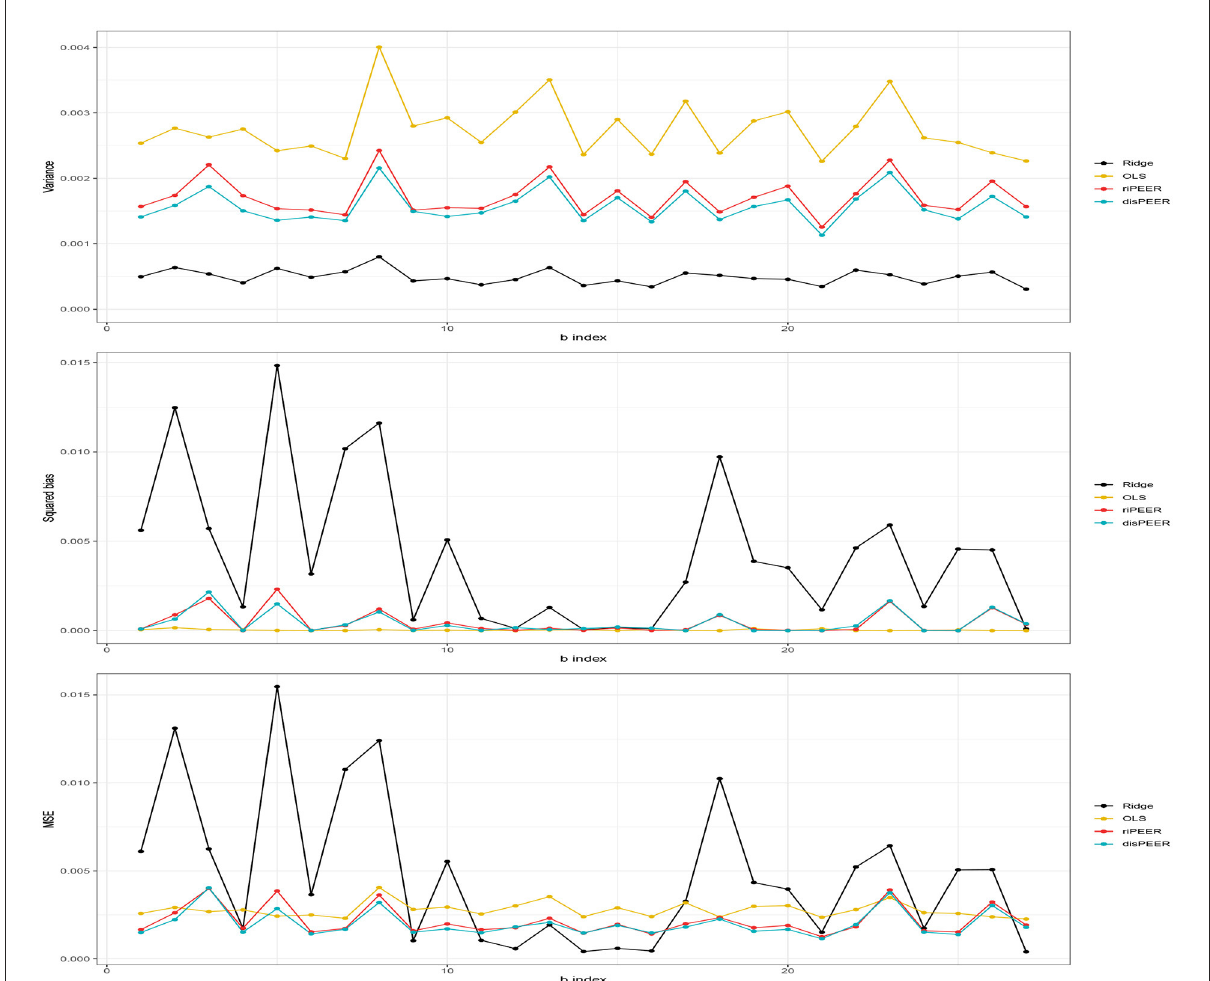
FIGURE7 Empirical variance, squared bias, and MSE of b estimates for σ b